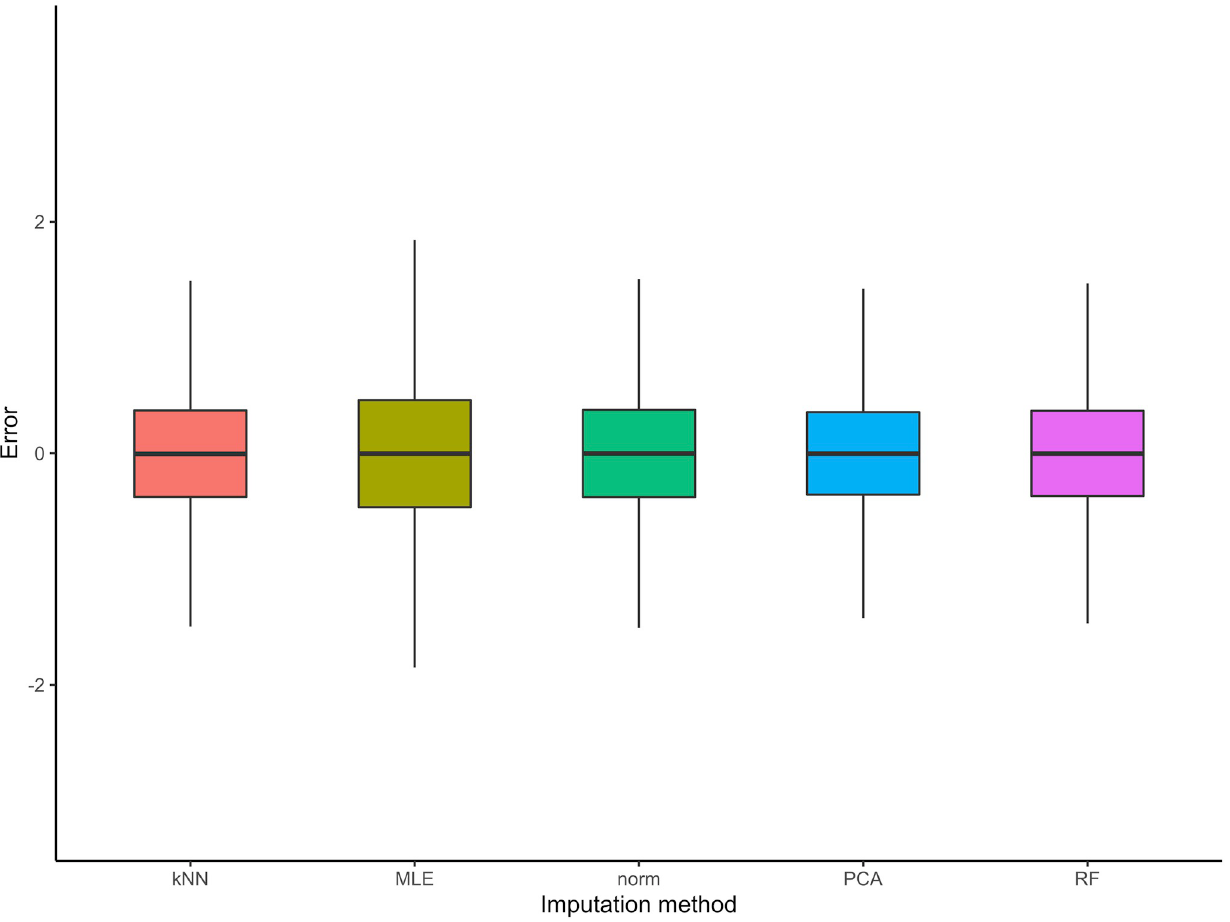
Fig 5. Distribution of errors of the averaged imputed values for the five imputation methods considered on the second set of MAR simulations.